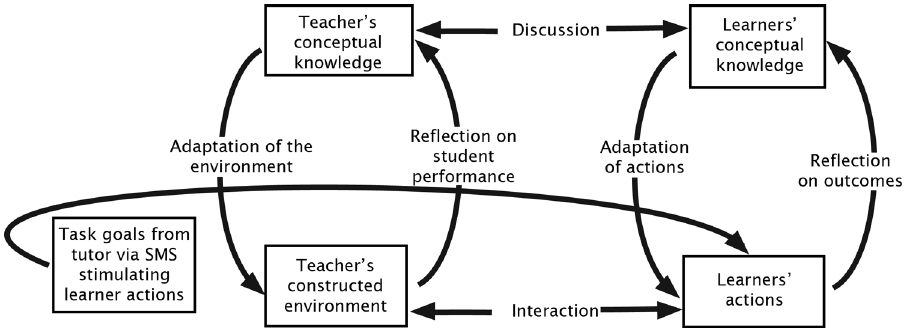
Figure 10. Using the Conversational Framework to locate the role of SMS